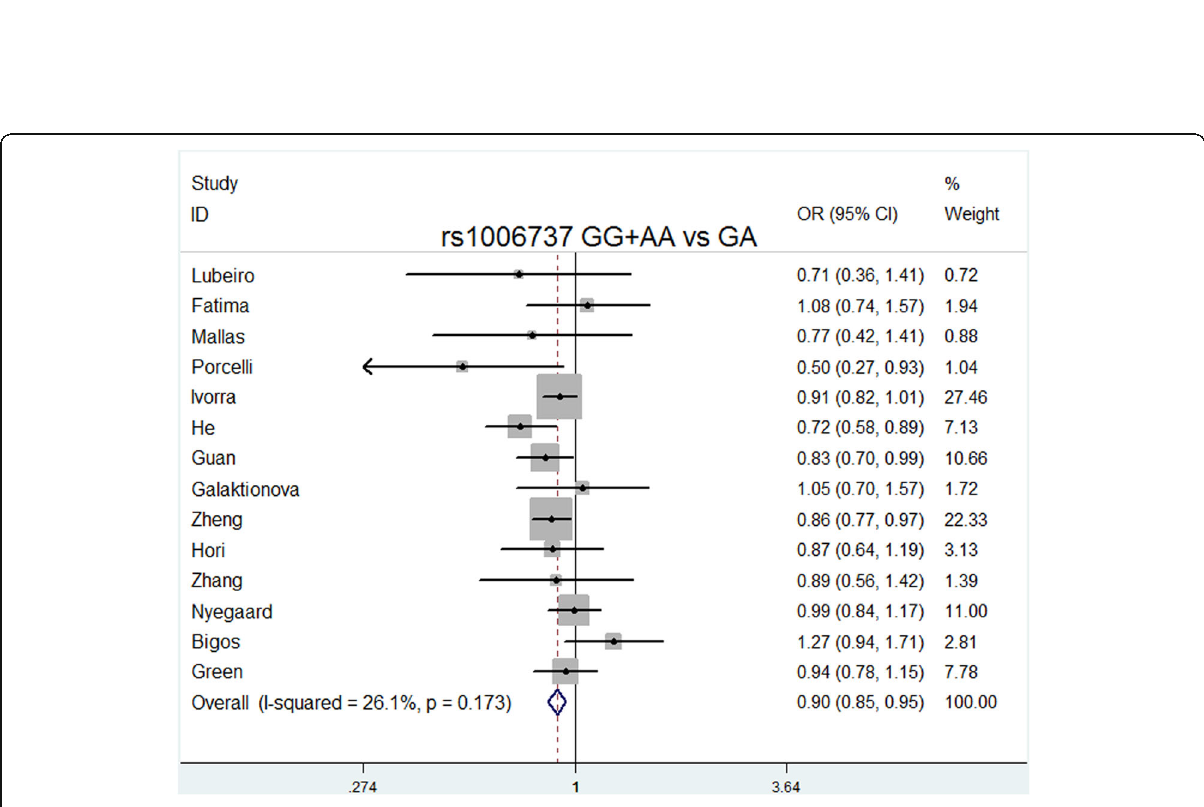
Fig. 7 Forest plot of the complete overdominance model (GG + AA vs. GA) for rs1006737. Significant differences between rs1006737 and the risk of schizophrenia were observed with the complete overdominance model (GG + AA vs. GA) (OR = 0.897, 95% CI = 0.849 – 0.948, P heterogeneity = 0.173, P =